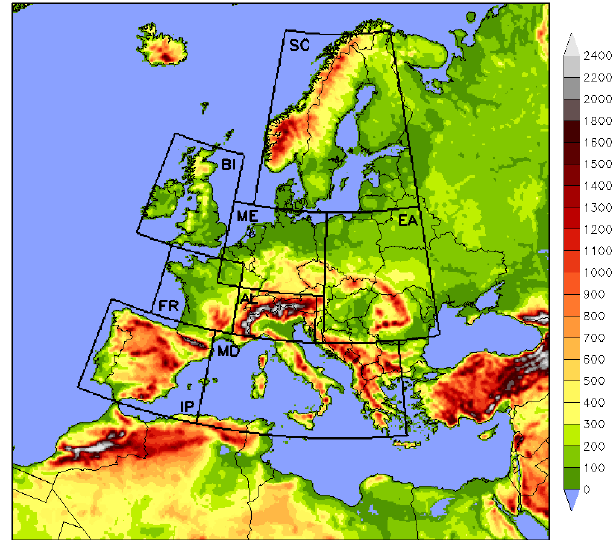
Figure 1. The common EURO-CORDEX analysis domain and location of the eight sub-domains used for model evaluation. The color represents the orography of the CLMCOM-11 setup [m].